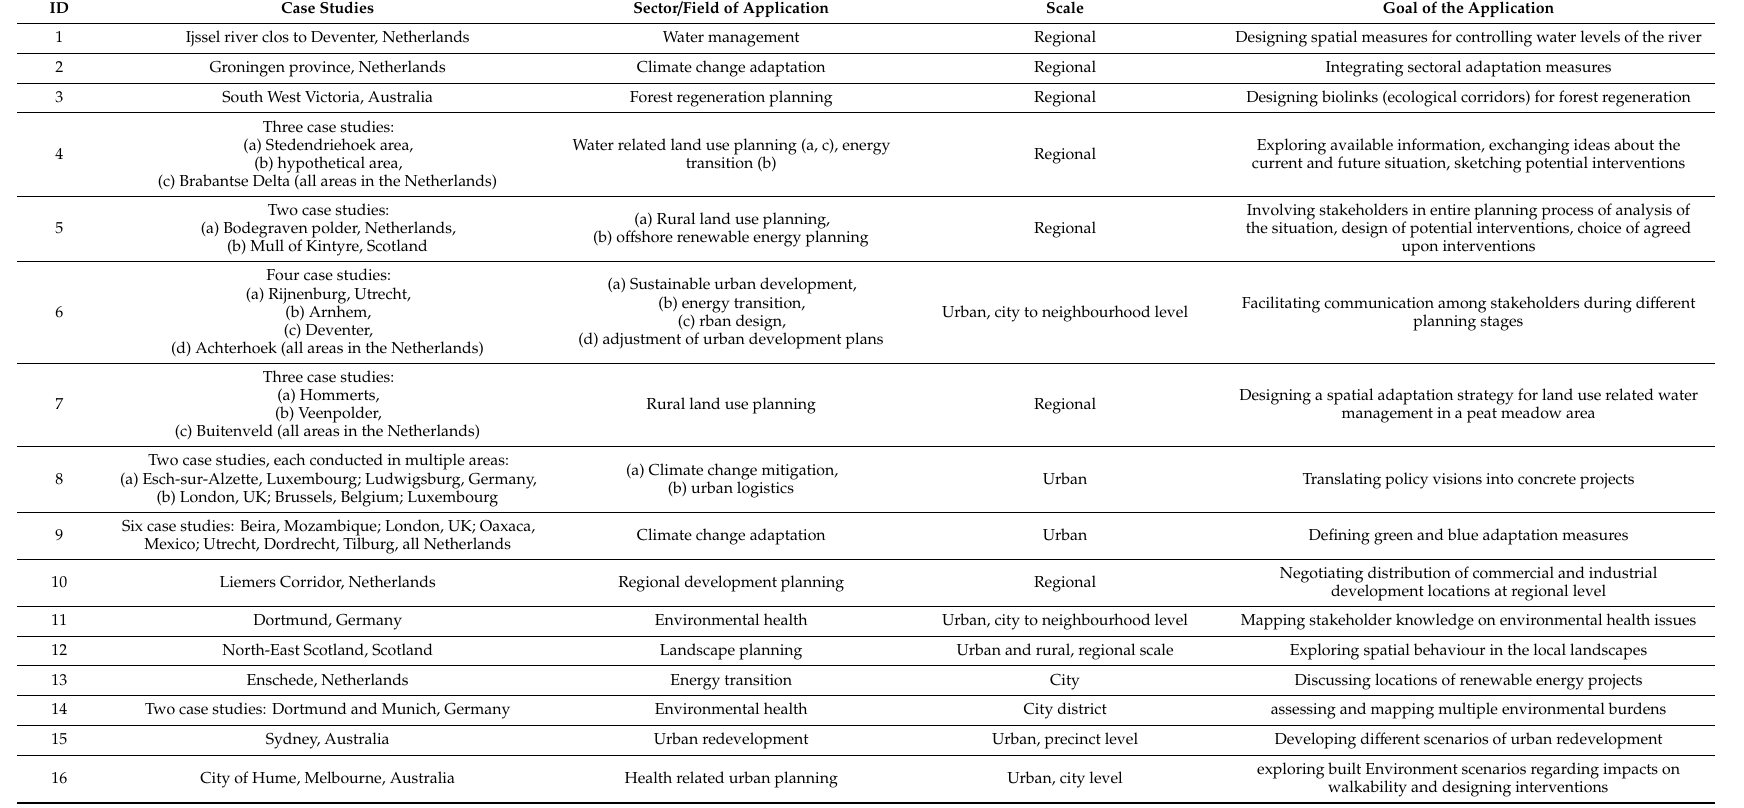
Table A1. Interactive PSS